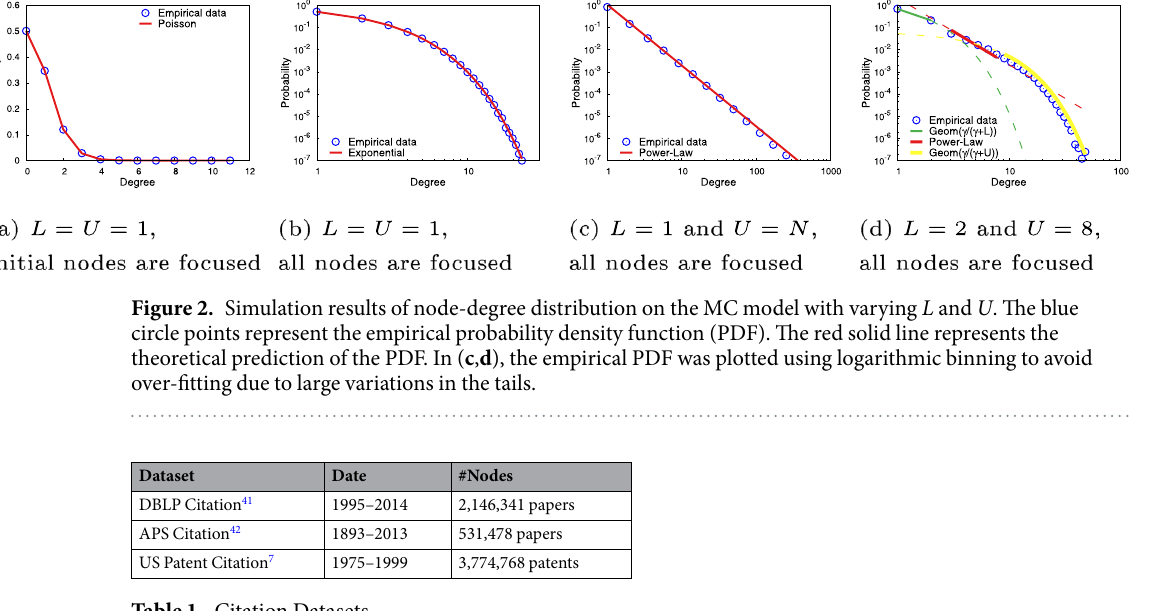
Table 1. Citation